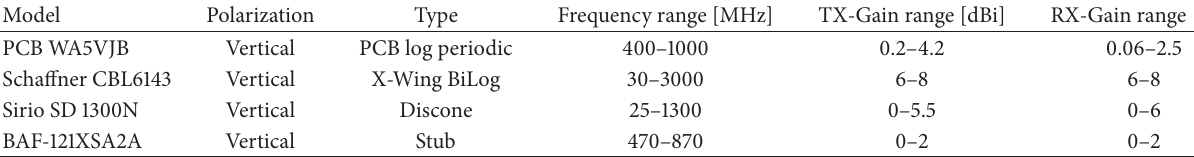
Table 2: Characteristics of the antennas used for the measurements.